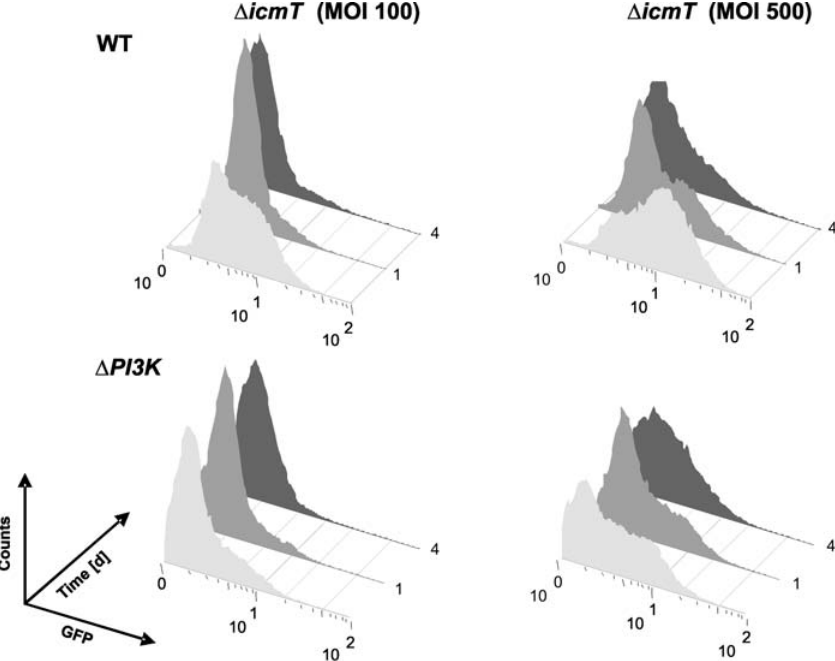
Figure 3. A Role for PI3Ks in Degradation of L. pneumophila D icmT Quantification by flow cytometry of intracellular degradation of GFP-labeled L. pneumophila D icmT (MOI 100, MOI 500) within wild-type Dictyostelium or D PI3K1/2. In the absence of PI3Ks, D icmT is less efficiently phagocytosed and degraded. DOI: